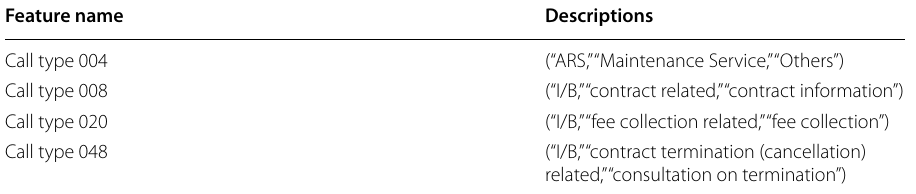
Table 3 Descriptions of the four call type features finally selected Feature name